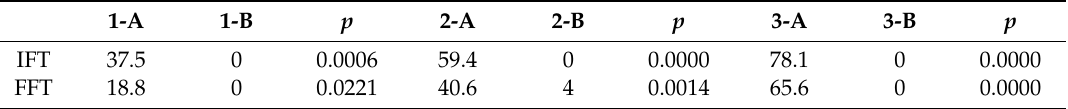
Table 4. Comparison of groups A with B using Student’s t-test (1-A, 2-A, 3-A—error percentages for group A for the respective velocities V1, V2, V3. The same designation was adopted for group B).